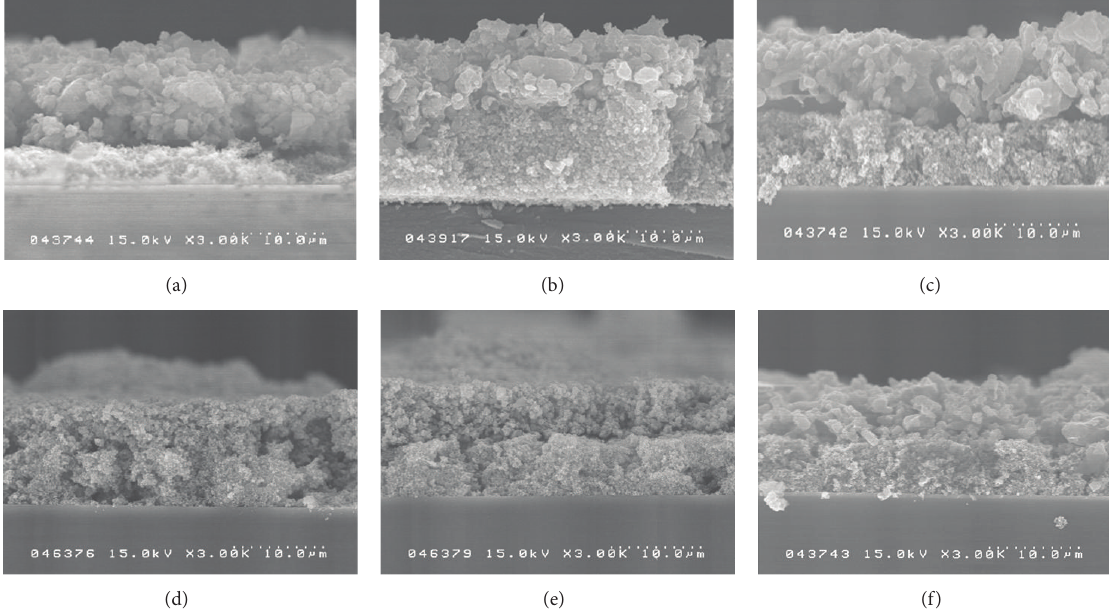
Figure 4: The cross section FESEM images of double TiO 2 layers with (a) 400 nm/5nm/FTO, (b) 400nm/100nm/FTO, (c) 400nm/200nm/ FTO, (d) 100nm/10nm/FTO, (e) 200nm/10nm/FTO, and (f)